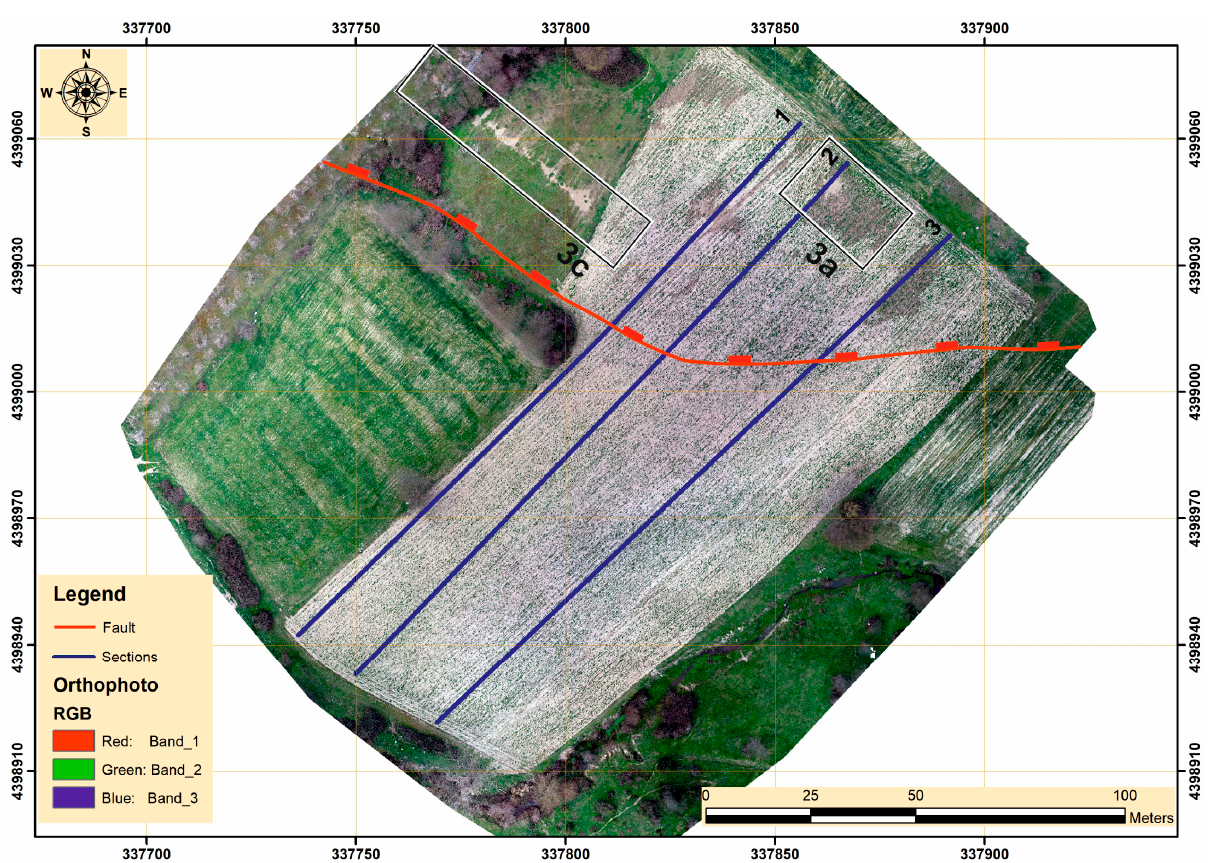
Figure 7. Fault scarp profiles across the VF coseismic ruptures (red arrow). For location of profiles, see the orthophoto map in Figure 8.